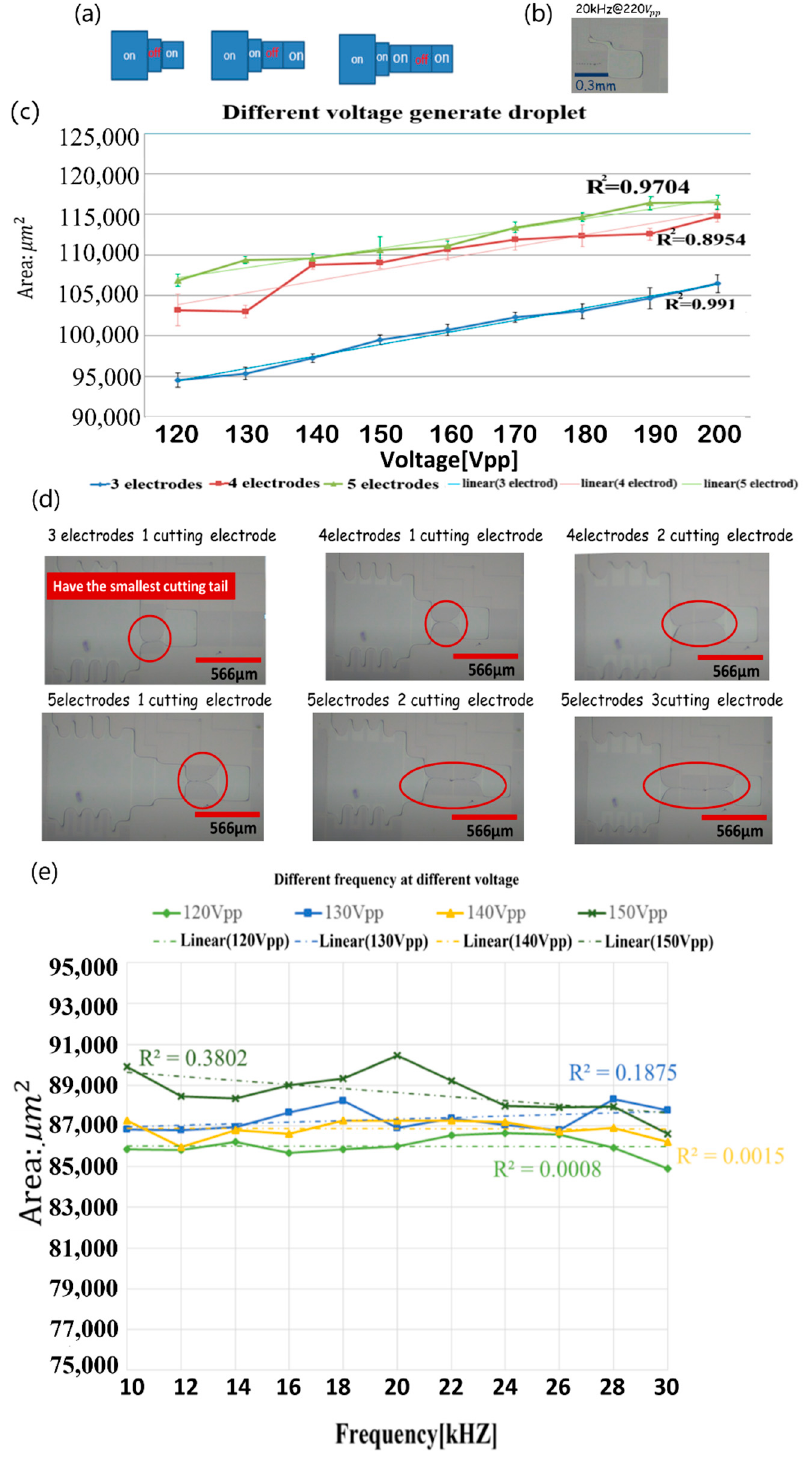
Figure 6. ( a ) Droplet generation with 3 electrodes, 4 electrodes and 5 electrodes; ( b ) liquid stretched on a wire at 220 Vpp; ( c ) variation of droplet size with voltage and number of electrodes; ( d ) dragging of the liquid tail phenomenon with different electrodes and cutting electrodes; ( e ) variation of droplet size with frequency at 120 Vpp, 130 Vpp, 140 Vpp and 150